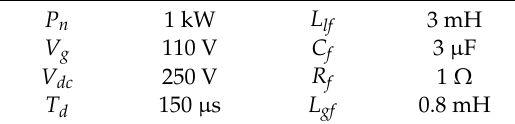
Figure 1. LCL based VSC system under parallel compensated grid. Table 1. kW voltage source converter (VSC) System.